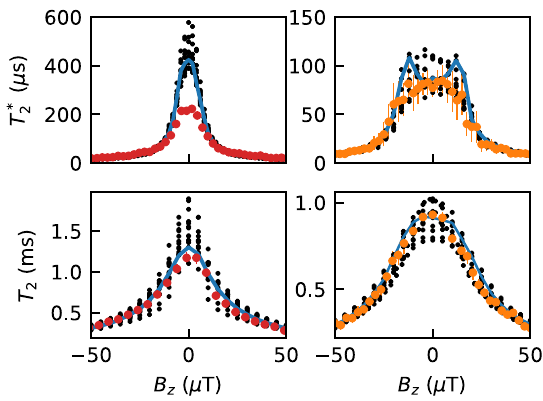
FIG. 12. Density matrix elements of the kh -V C V Si divacancy for two random nuclear spin spatial configurations of a weakly coupled nuclear bath (in columns) as a function of the magnetic field. The lines with brighter color correspond to the exact solu- tion for a smaller bath (nine nuclear spins). The dotted white line corresponds to the initial value of ρ ii . We set ρ 00 = 0.5 for all calculations.